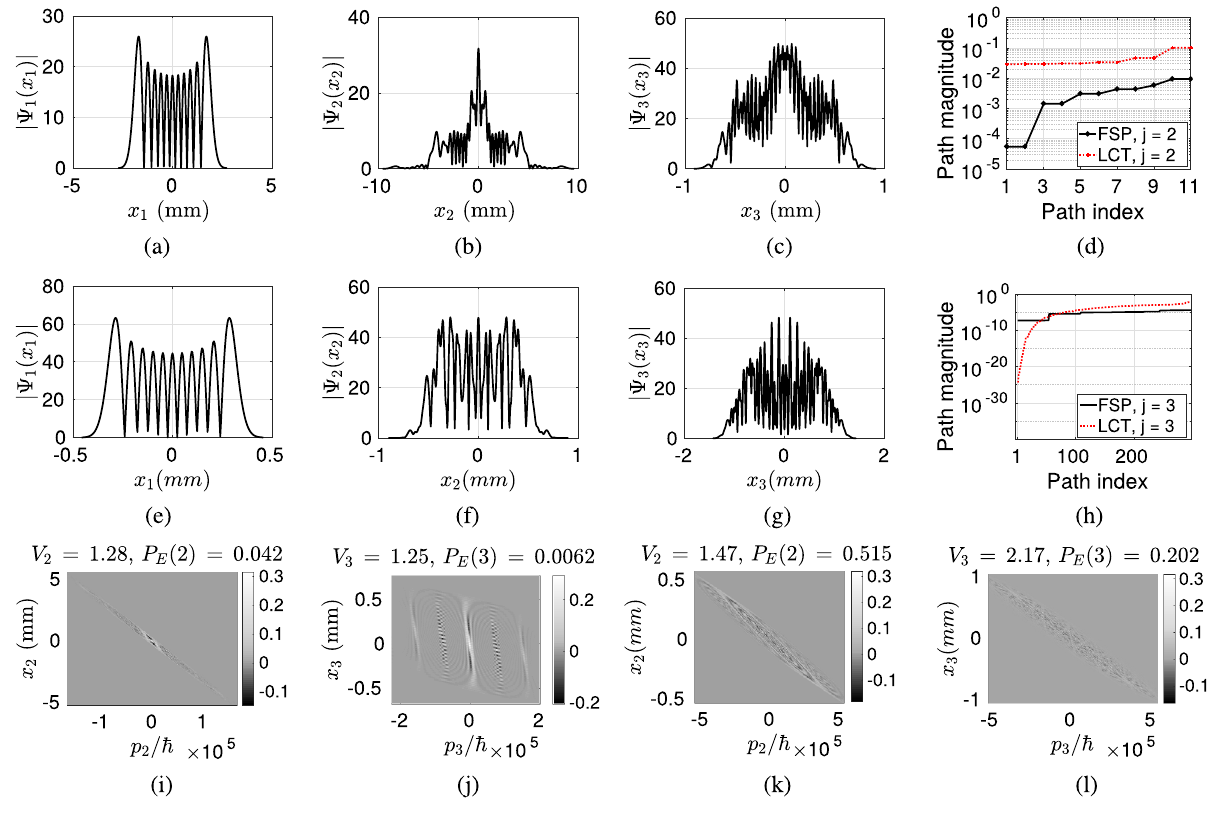
10 and W 0 200 µ m is utilized where the resulting spatial domain Figure 9. HG source with the order of l = = 1 , ( b ) j 2 and ( c ) j 3 for FSP, and ( e ) j 1 , ( f ) j 2 and waveforms on the planes with the indices ( a ) j = = = = = 3 for LCT. P , j ) for ( d ) j 2 and ( h ) j 3 . Scaled Wigner distribution (cid:31) W j ( x j , p j ) for FSP on the ( g ) j E ( n = = = × 2 and ( j ) j 3 , and for LCT with ( k ) j 2 and ( l ) j 3 planes with ( i ) j = = = =